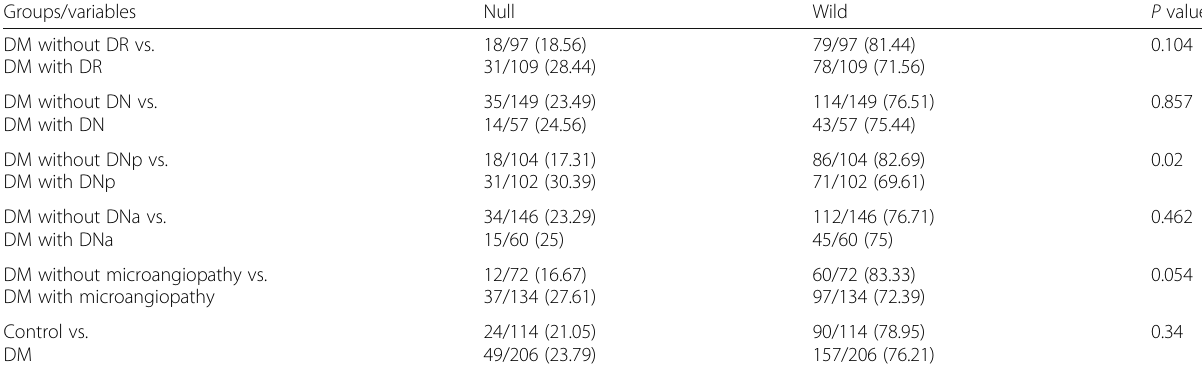
Table 4 The relationship between GSTT1 genotypes and microangiopathic complications in diabetic patients